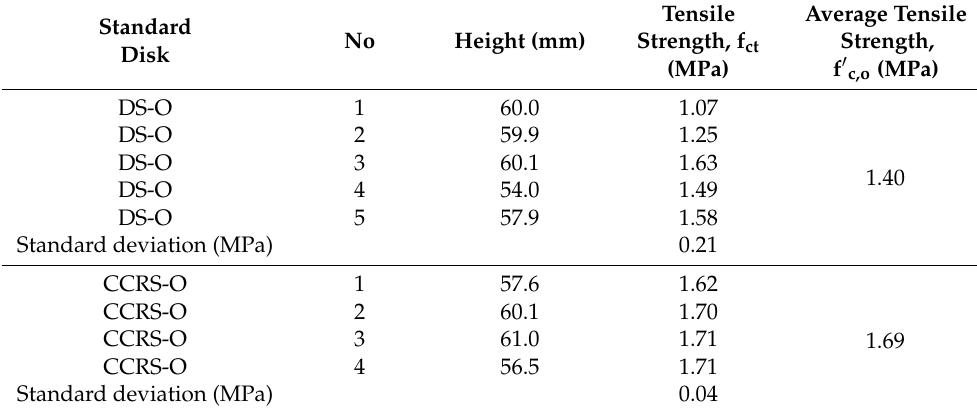
Table 4. Splitting tensile test results.